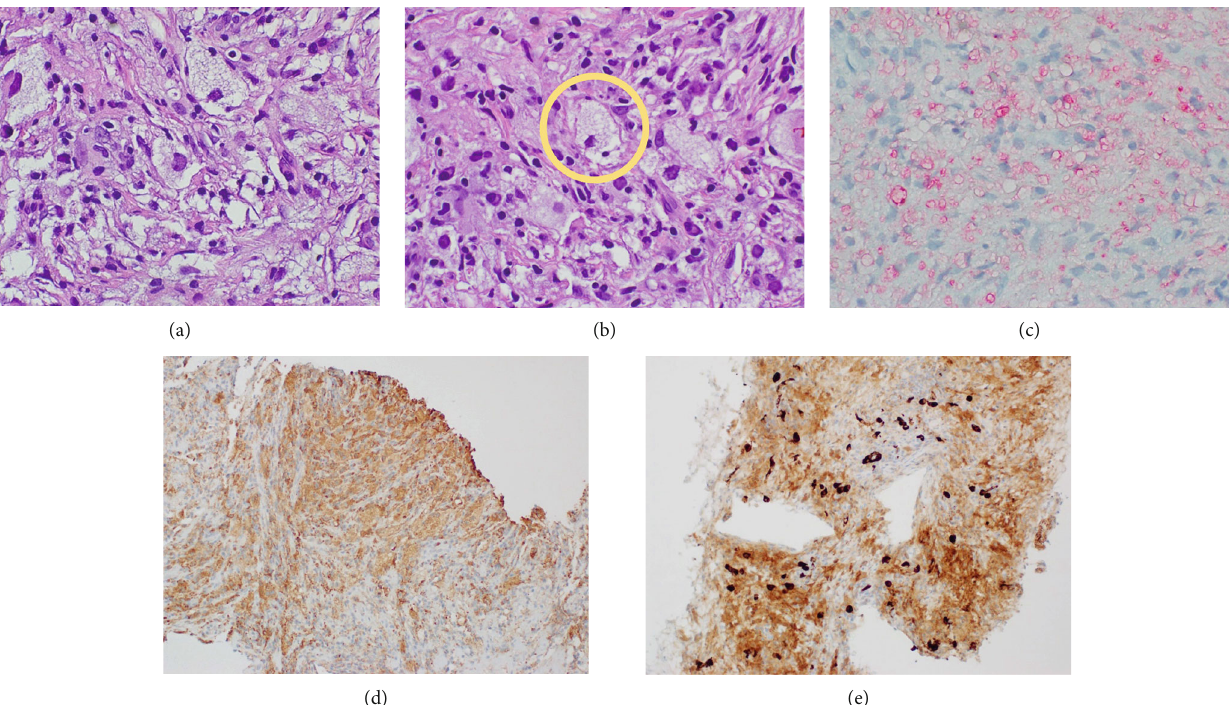
Figure 5: (a) Histiocytes with characteristic prominent nucleoli and pale abundant cytoplasm (hematoxylin and eosin, 600x). (b) Histiocytes with emperipolesis (hematoxylin and eosin, 600x). (c) Immunohistochemistry of the appendiceal mass with S-100 highlighting large histiocytes with prominent nucleoli (600x). (d) Immunohistochemistry of the appendiceal mass with CD68 highlighting large areas of histiocytes. (e) Immunohistochemistry of the appendiceal mass with IgG4-positive